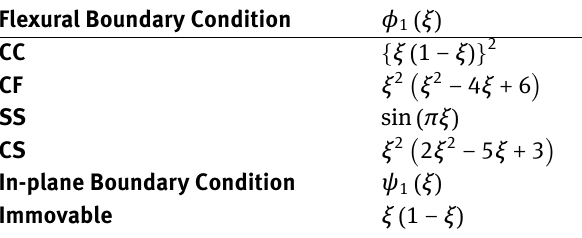
Table 1: Base functions for assume displacement field ( w , u ).